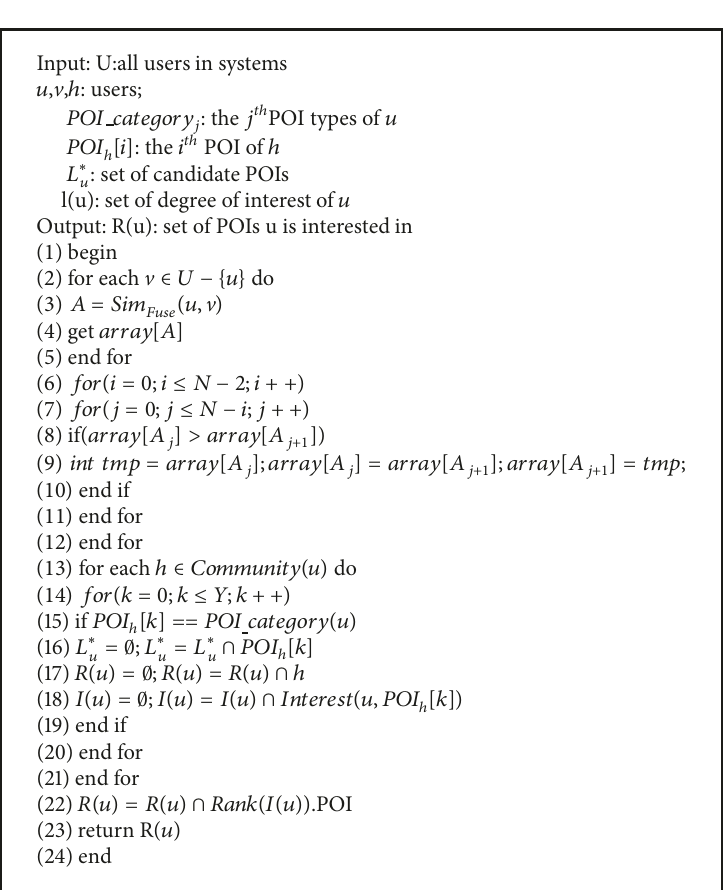
Algorithm 1: Travel-community- (TC-) based POI